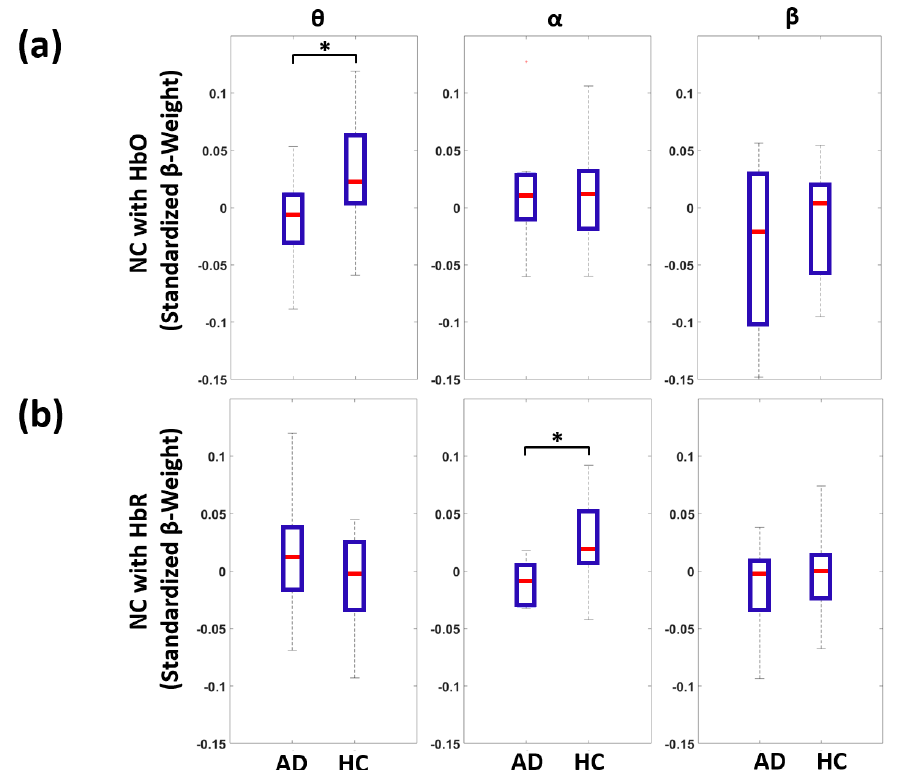
Figure 5. Boxplots showing the average standardized β-weights among the long separation fNIRS channels (global NCs) for AD and HC. ( a ) Global NC of theta, alpha and beta bands with HbO. ( b ) Global NC of theta, alpha and beta bands with HbR (* p < 0.05).